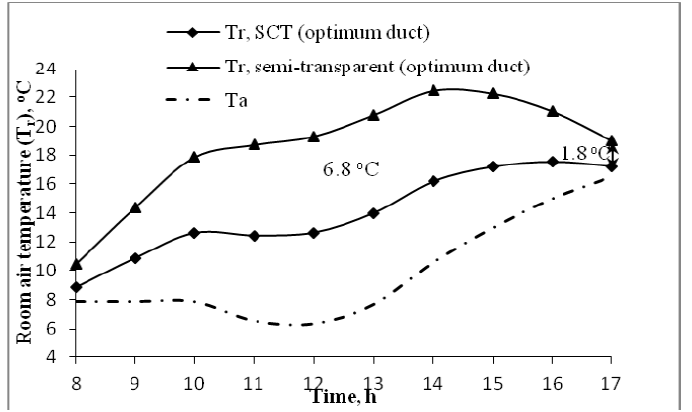
Figure 5. Variation of thermal energy w.r.t number of air